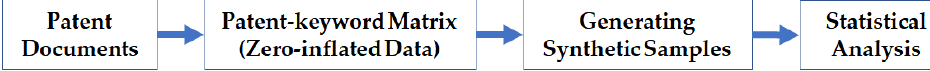
Figure 3. Proposed method for zero-inflated data analysis.